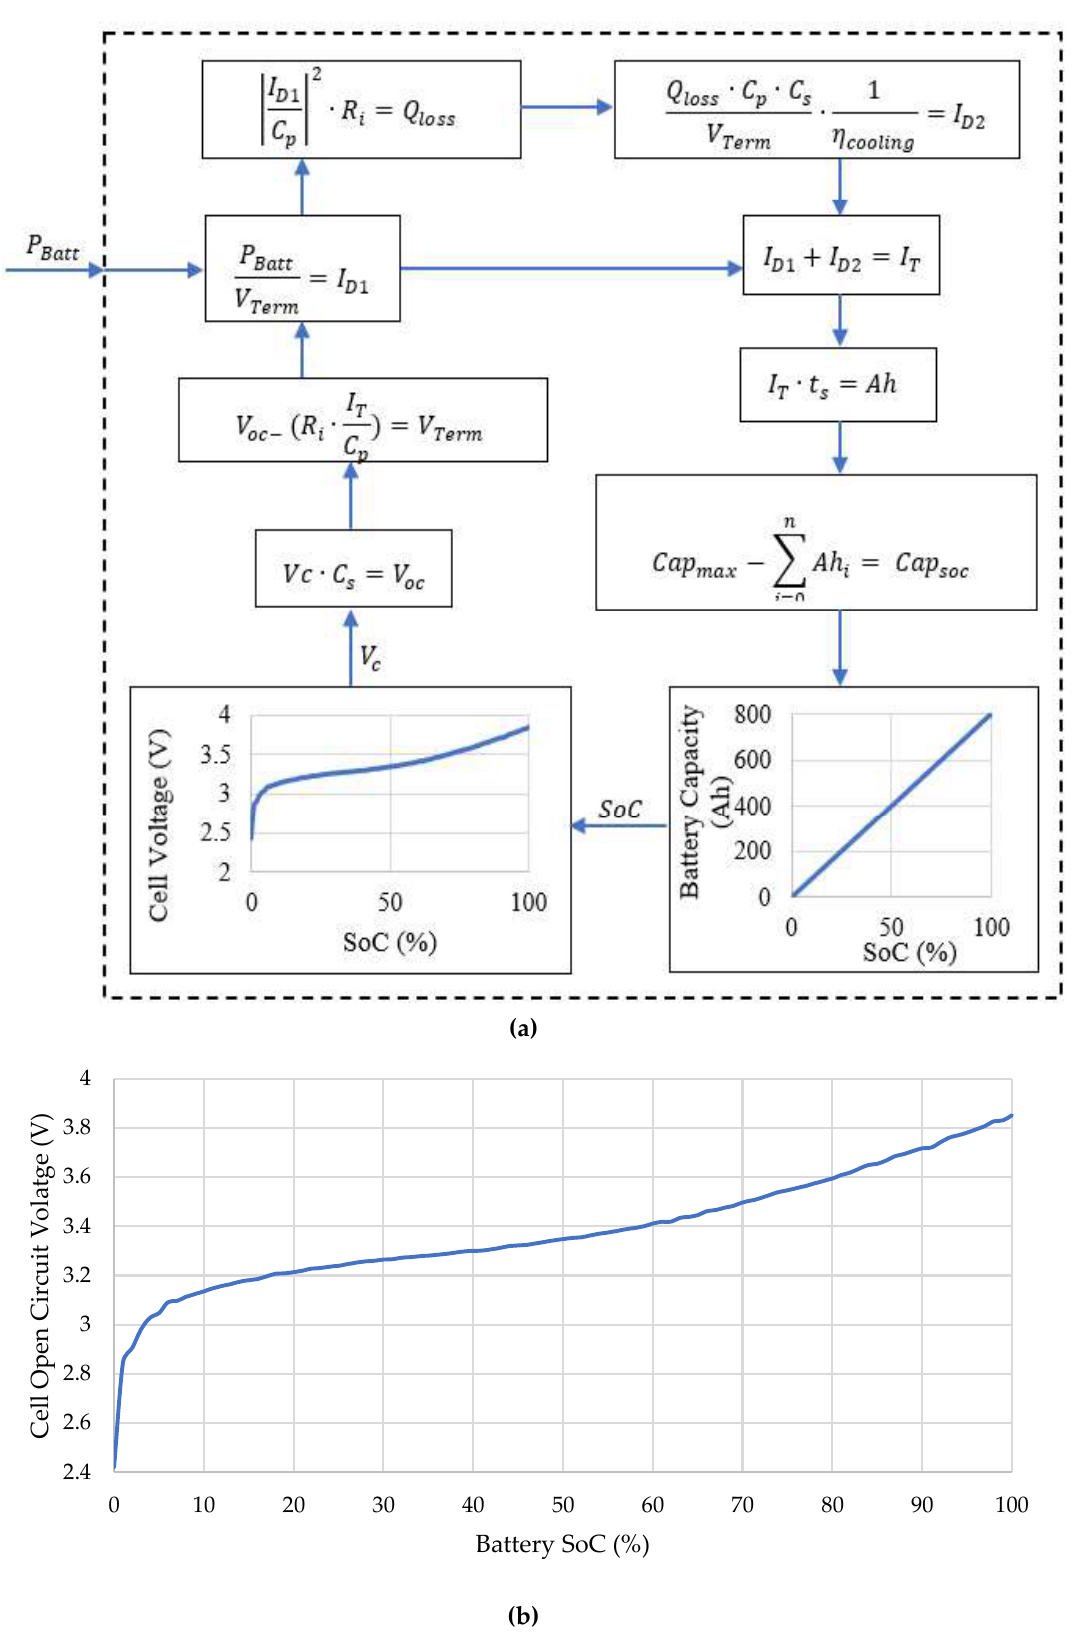
Figure 9. ( a ) Scalable prismatic battery model with cooling system; ( b ) cell OCV curve used in simulations.